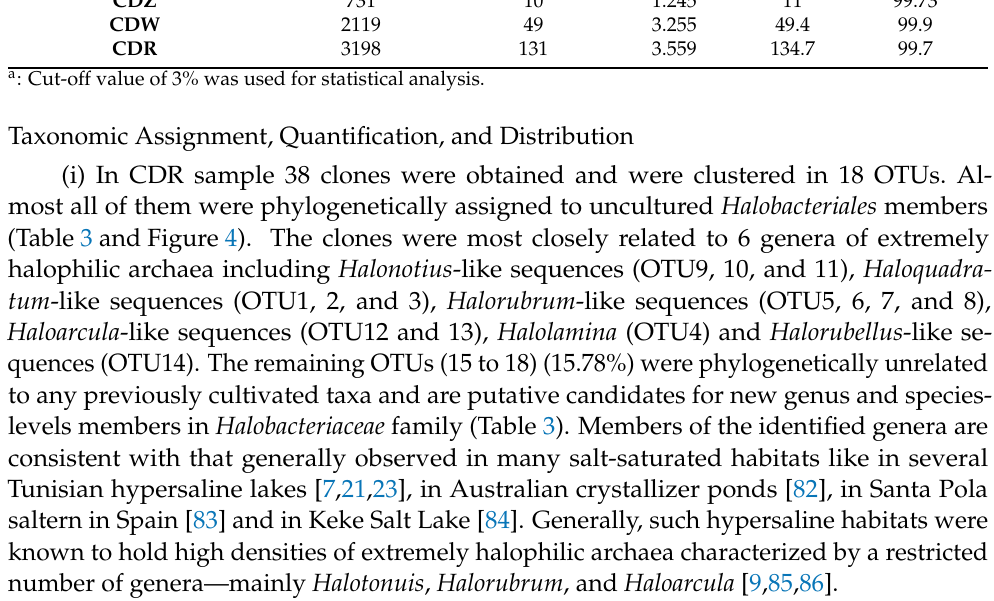
Table 4. Alpha diversity of archaeal community of different halite-crystal salt samples (CDR, CDW, CDZ) of 16S rRNA Clones libraries and metataxonomic approaches Samples and Approaches 16S rRNA Clones libraries